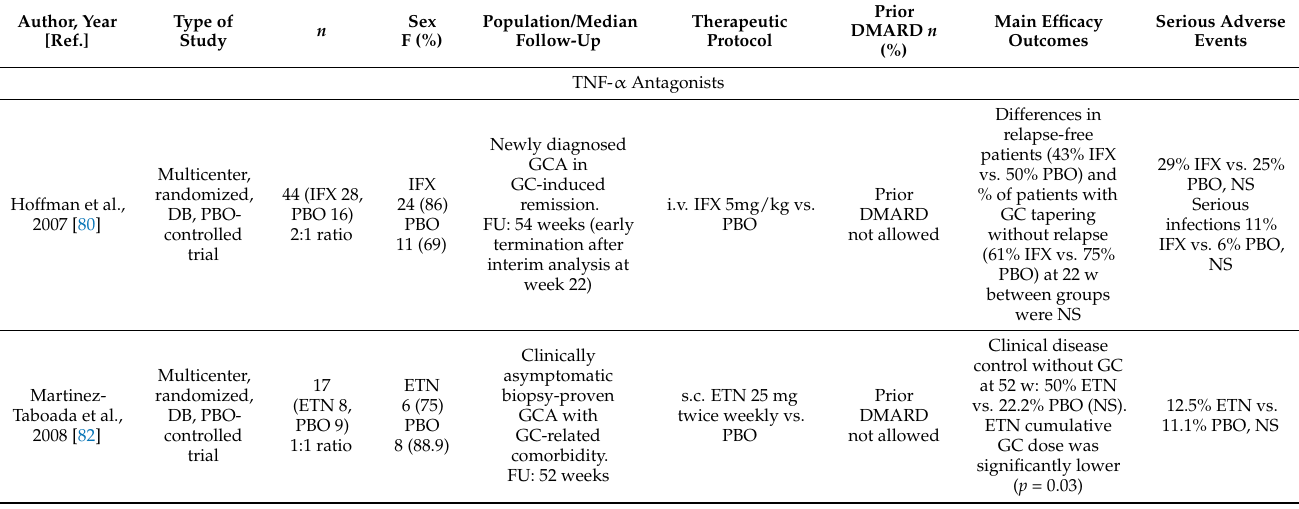
Table 2. Role of non-tocilizumab biologic disease-modifying antirheumatic drugs in giant cell